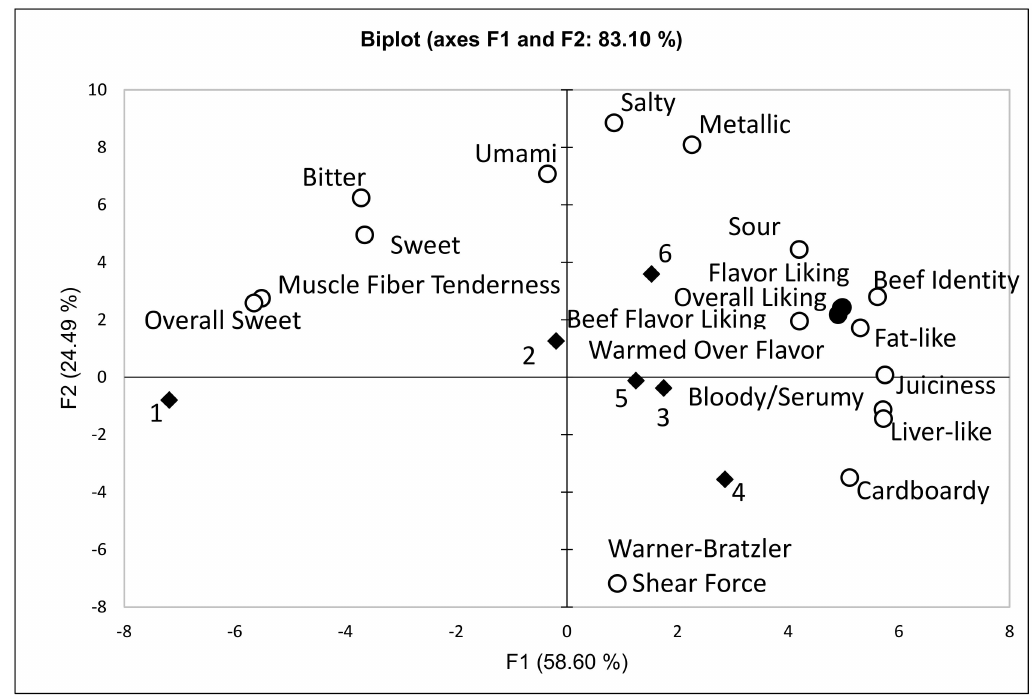
Figure 2. Principal component biplot of selected data from Laird (2015) [83] and Luckemeyer (2015) [82] using the six consumer liking clusters from Table 2. ( (cid:7) ), descriptive flavor and texture attributes and WBSF values ( ◦ ), and consumer sensory attributes ( •